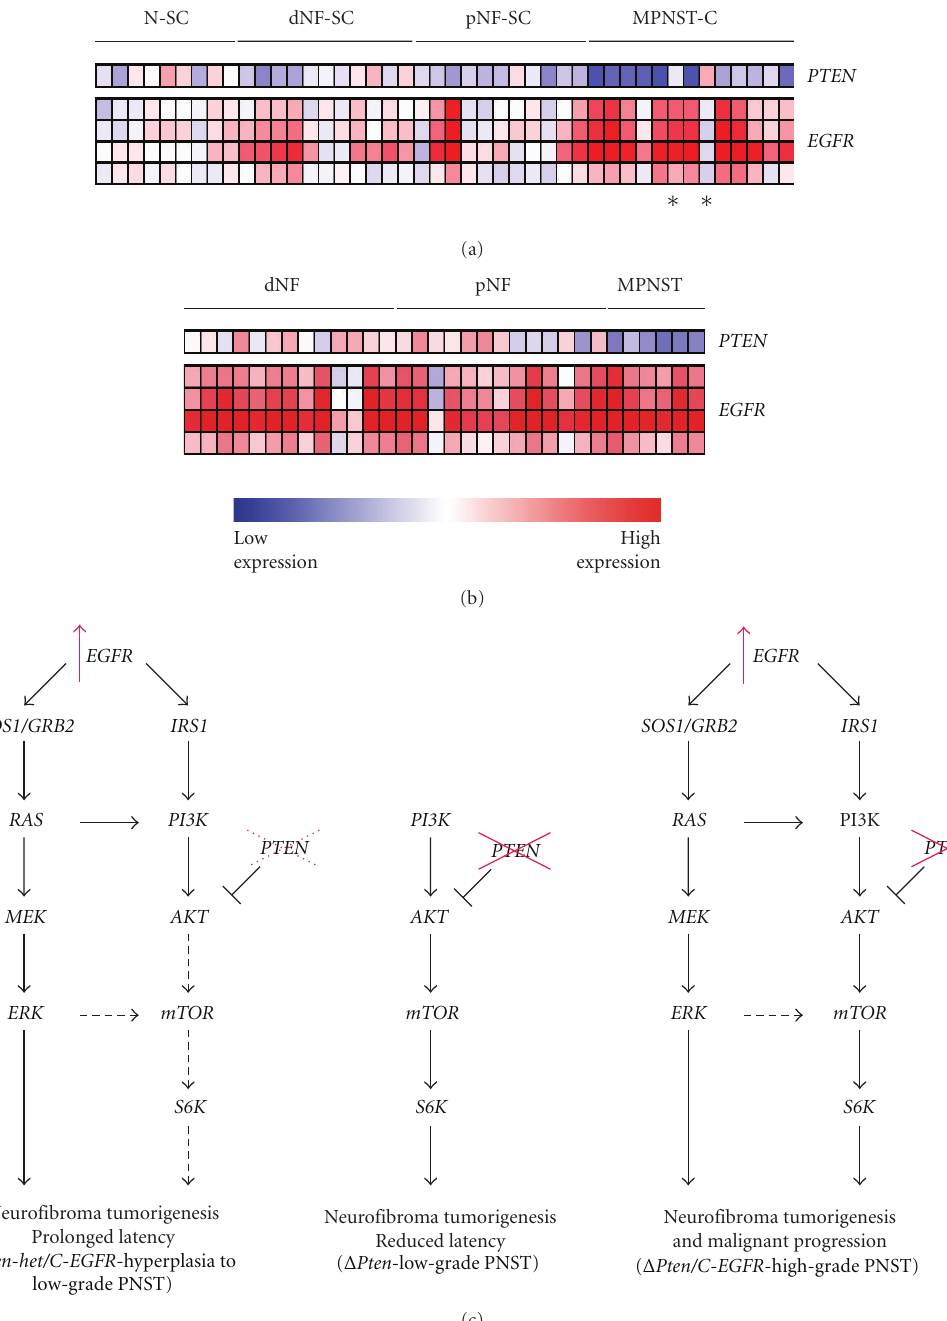
Figure 4: Expression microarray analysis of PTEN and EGFR in human peripheral nerve tumors. (a) Purified human Schwann cells from normal sciatic nerve (N-SC), dermal neurofibroma cell lines (dNF-SC), and plexiform neurofibroma cell lines (pNF-SC). Transformed cells from malignant peripheral nerve sheath cell lines (MPNST-C). Asterisks indicate sporadic MPNST samples. (b) Solid dermal neurofibromas (dNF), plexiform neurofibromas (pNF), and malignant peripheral nerve sheath tumors (MPNST). Four di ff erent probes for EGFR were used. Red, increase in red intensity as expression increases; Blue, increase in blue intensity as expression decreases. (c) Conditional inactivation of Pten and EGFR overexpression in Schwann cells resulted in high-grade PNST initiation and/or progression due to the upregulation of both Ras / Mapk/Erk and Pi3k / Akt / mTor signaling pathways ( right ). Inactivation of Pten alone resulted in reduced latency with low-grade PNST tumorigenesis at low penetrance ( middle ). Conditional inactivation of Pten alone can result in low-grade PNST tumorigenesis via the upregulation of the Pi3k / Akt / mTor signaling pathway. Partial conditional inactivation of Pten in the context of EGFR overexpression in Schwann cells resulted in prolonged latency with hyperplasia to low-grade PNST tumorigenesis at low penetrance ( left ), resulting in upregulation of Ras / Mapk/Erk and slight upregulation of the Pi3k / Akt / mTor signaling pathways. SOS1 : son of sevenless homolog 1 ; GRB2 : growth factor receptor-bound protein 2 ; IRS2 : insulin receptor substrate 2 ; Dhh -Cre; Pten flox/flox ; EGFR ( Δ Pten/C - EGFR ), Dhh -Cre; Pten flox/ + ; EGFR ( Pten - het/C - EGFR ) and Dhh -Cre; Pten flox/flox ( Δ Pten )